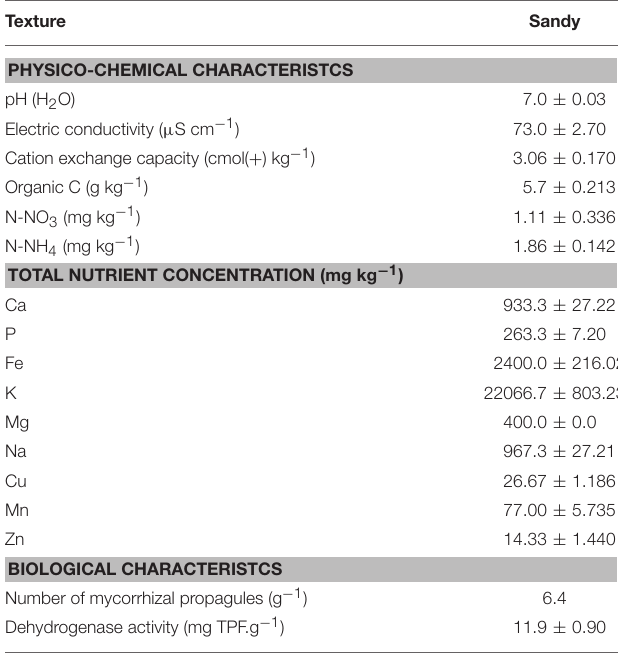
TABLE 1 | Physico-chemical and biological parameters of the soil used in the experiment.